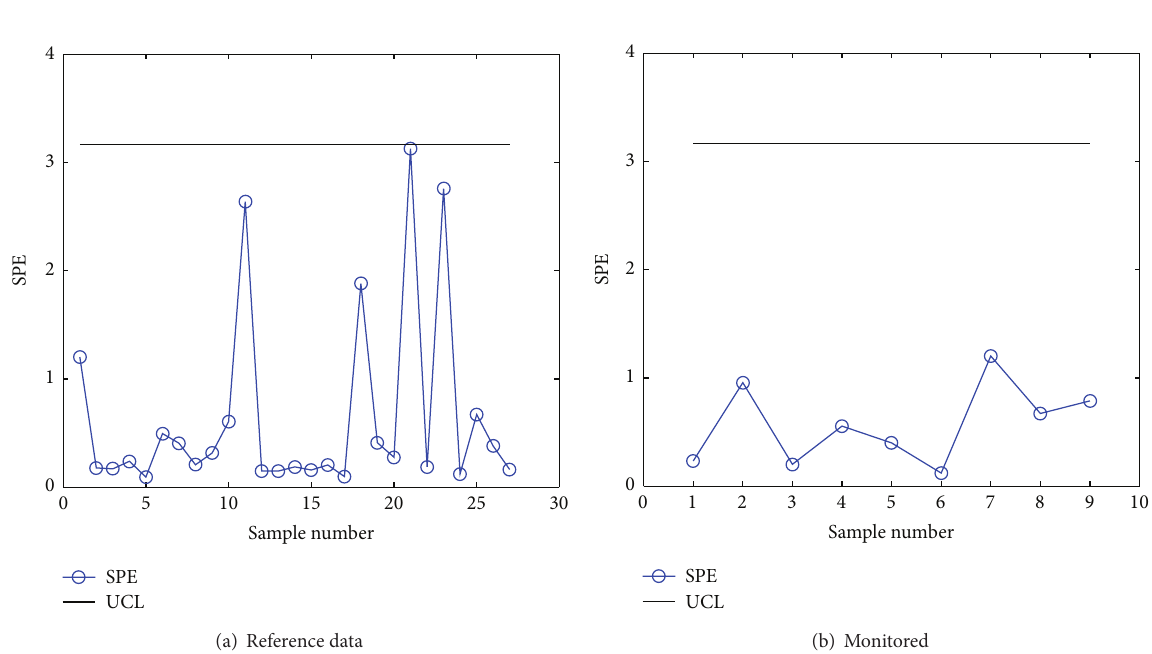
Figure 10: Monitoring charts of KPCA using natural